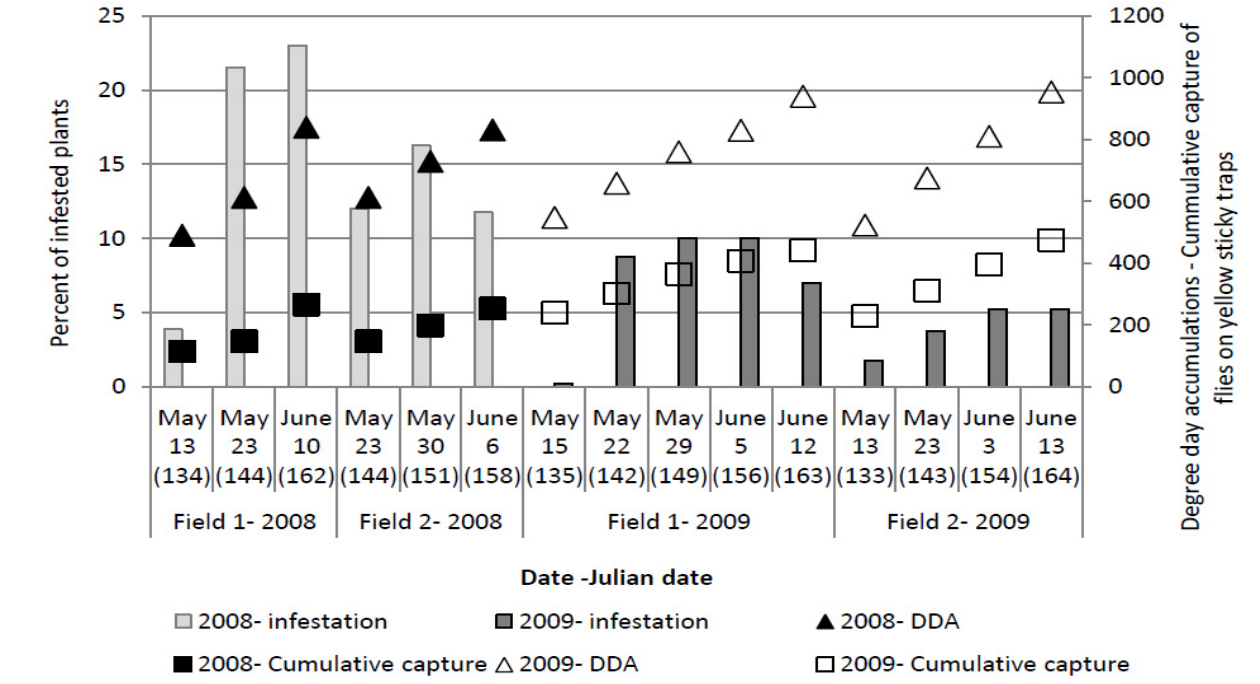
Figure 4. The average percent of plants showing symptoms of larval infestation by Delia radicum (L.) over two field seasons (2008,